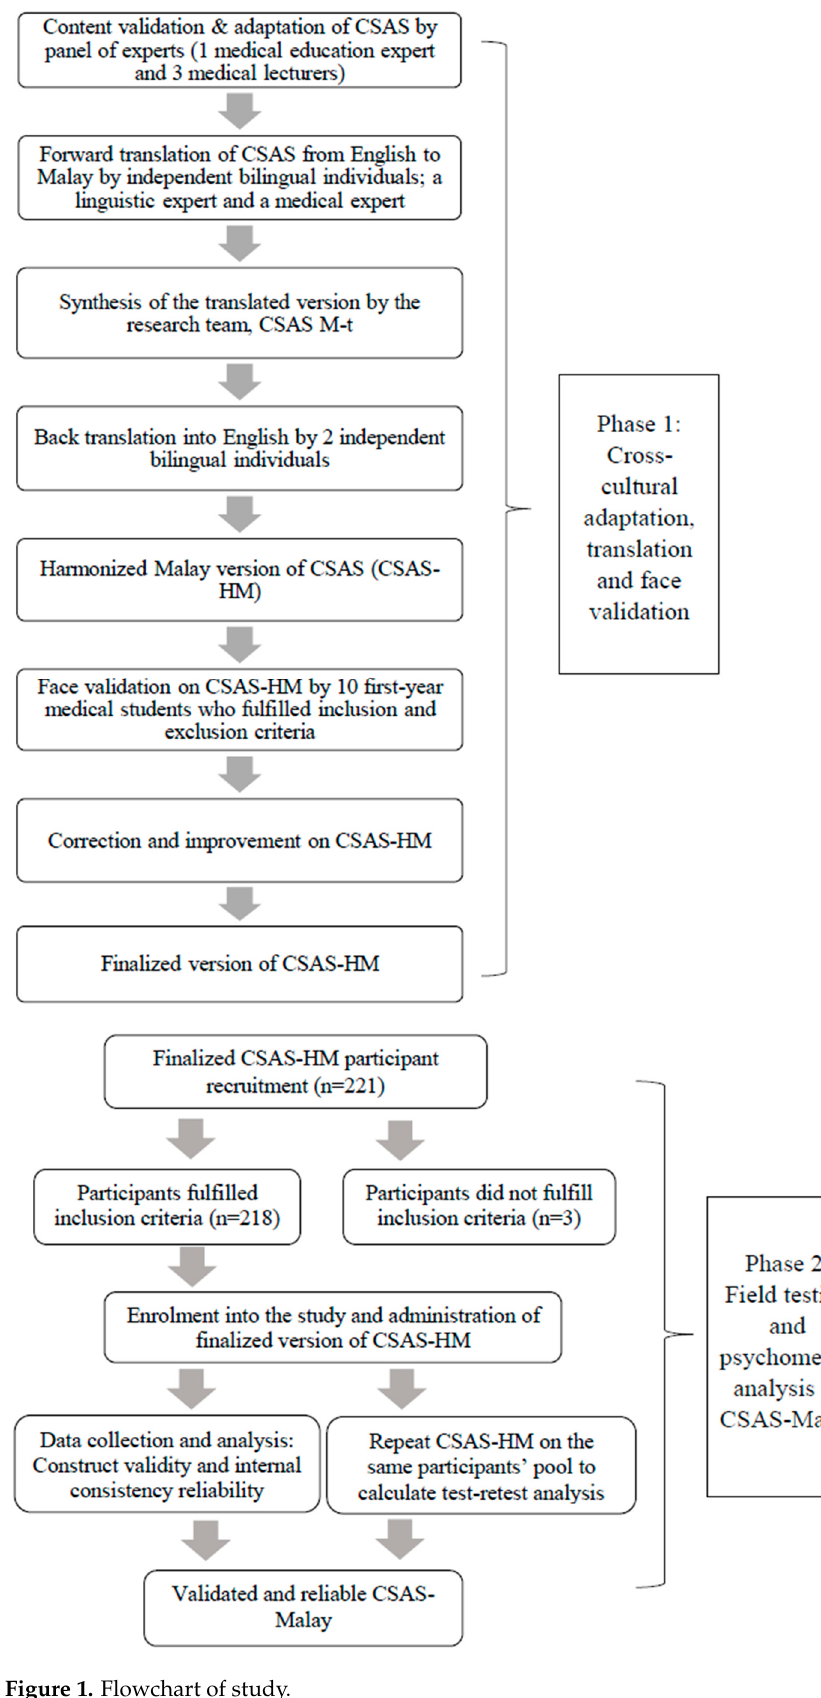
Figure 1. Flowchart of study.